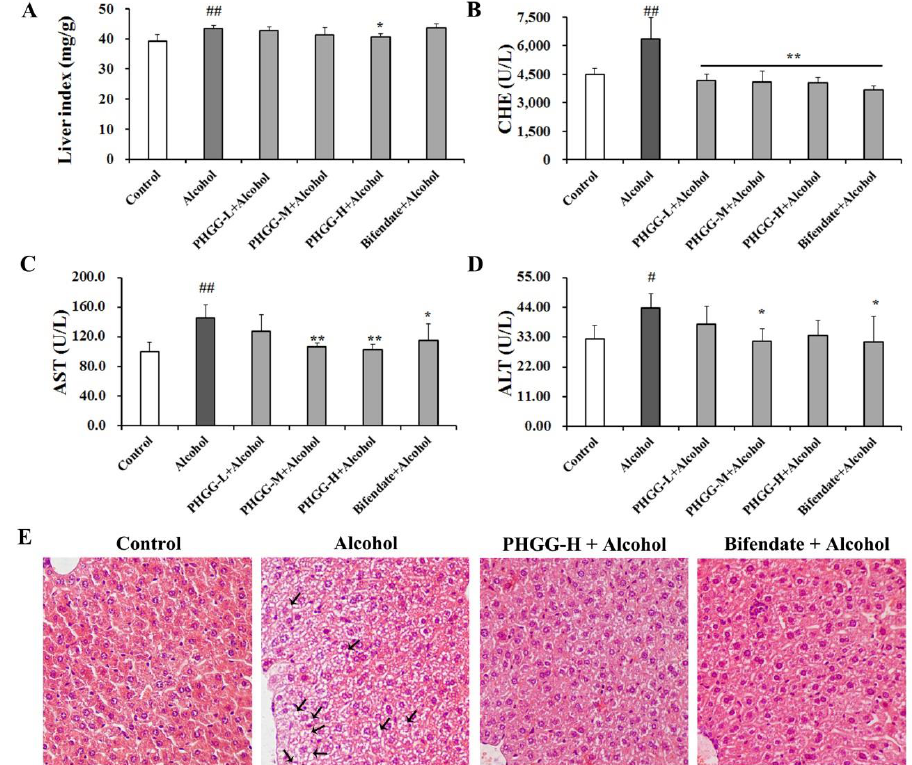
Figure 2. E ff ect of partially hydrolyzed guar gum (PHGG) on alcohol-induced liver damage. Liver index ( A ), serum cholinesterase (CHE) ( B ), aspartate aminotransferase (AST) ( C ), and alanine aminotransferase (ALT) ( D ) levels were measured as indicators of alcohol-induced liver damage. Histomorphology examination from mice of di ff erent treatment groups—Control group, Alcohol group, PHGG-H + Alcohol group, and Bifendate (150 mg / kg · day) + Alcohol group on liver sections (1 : 200)—was visualized by H&E staining ( E ). Results are shown as mean ± SD ( n = 10) of three independent experiments. “#” ( p < 0.05) and “##” ( p < 0.01), significantly di ff erent when compared to the Control group. “*” ( p < 0.05) and “**” ( p < 0.01), significantly di ff erent when compared to the Alcohol group. PHGG-L + Alcohol: PHGG low dose + alcohol group, treated with 500 mg / kg · day of PHGG plus alcohol; PHGG-M + Alcohol: PHGG medium dose + alcohol group, treated with 1000 mg / kg · day of PHGG plus alcohol; PHGG-H + Alcohol: PHGG high dose + alcohol group, treated with 2000 mg / kg · day of PHGG plus